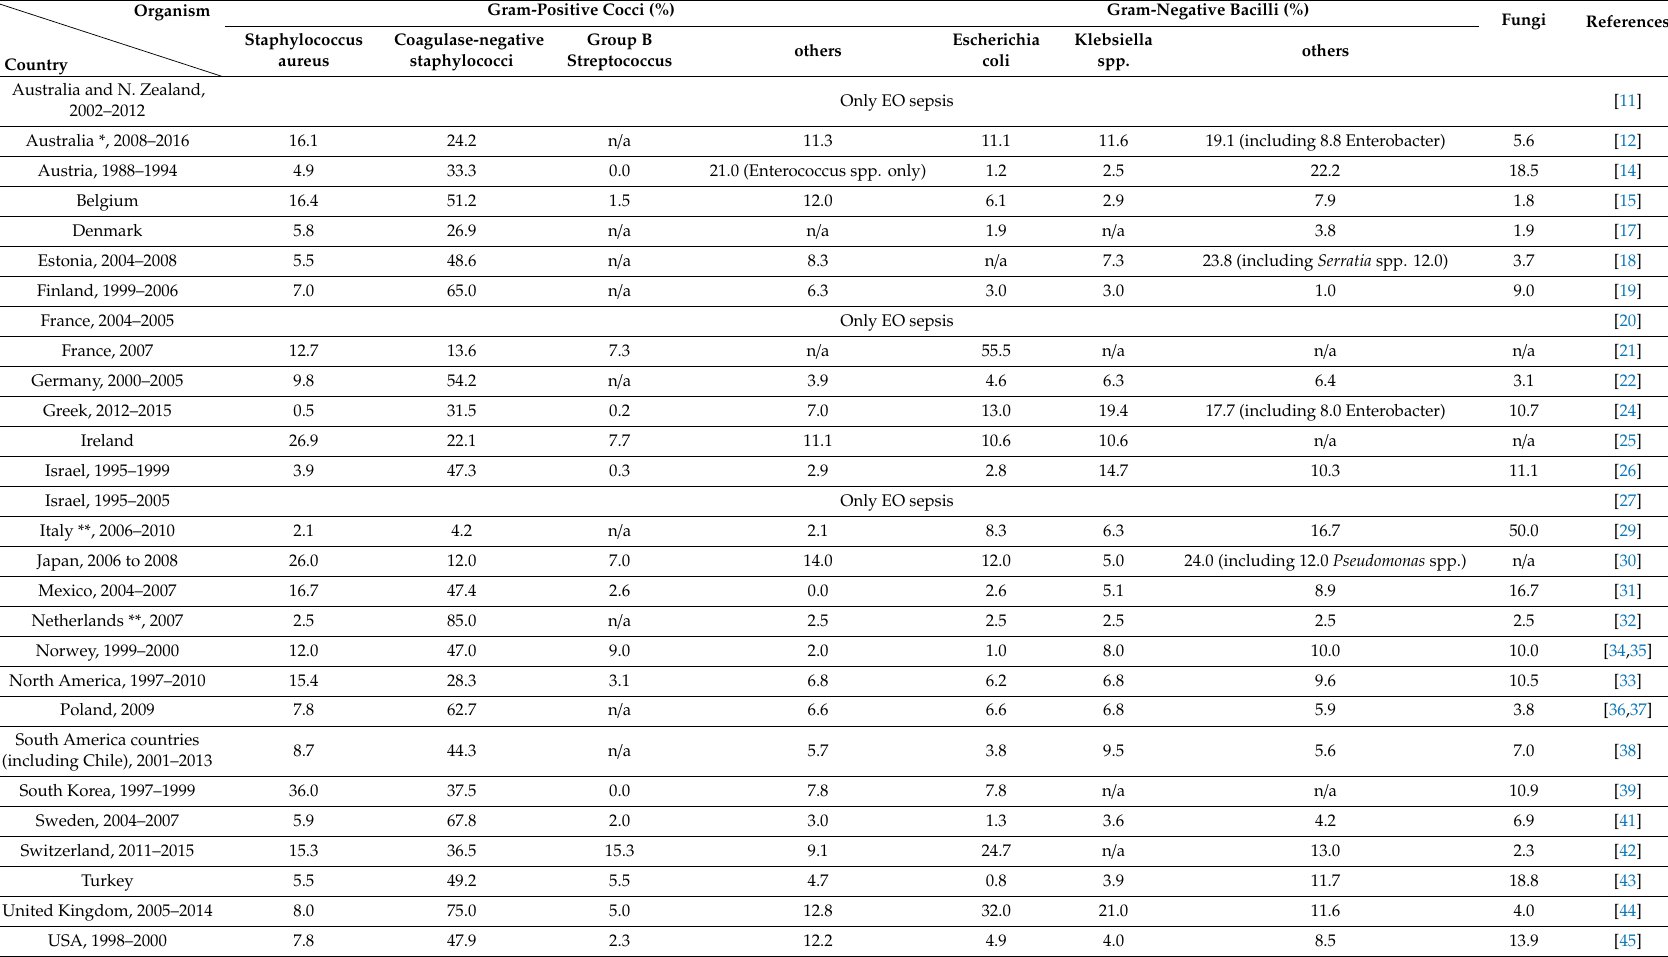
Table 5. Share of the most common species of Gram-positive cocci, Gram-negative bacilli, and fungi in late-onset neonatal sepsis (in alphabetical order).